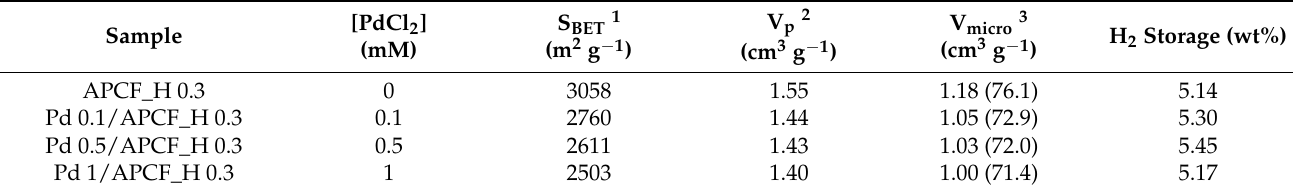
Table 3. Surface area, microporosity, and hydrogen storage capacity at 77 K and 10 MPa of Pd-deposited APCF_H